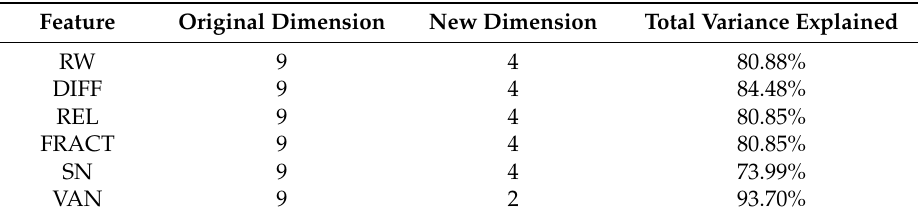
Table 7. Total variance explained for all features.